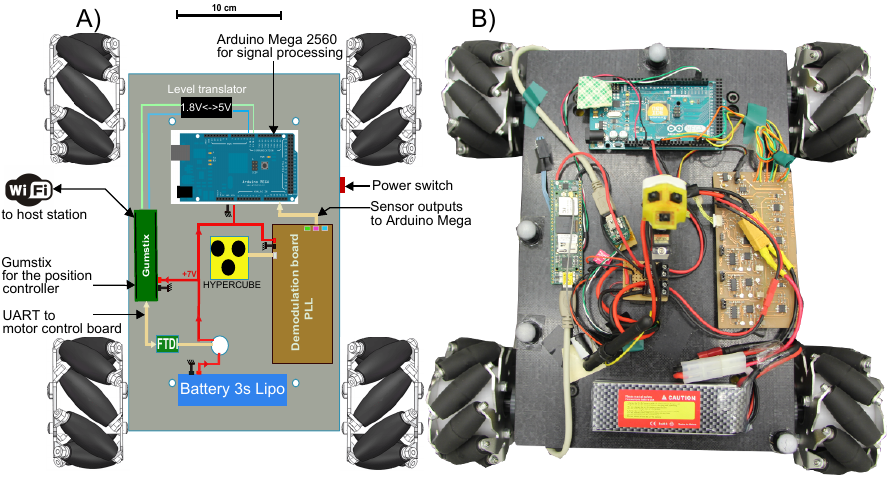
Figure 11. Top view of the mobile robot: ( A ) schematic of the embedded hardware; and ( B ) picture of the mobile robot used for the